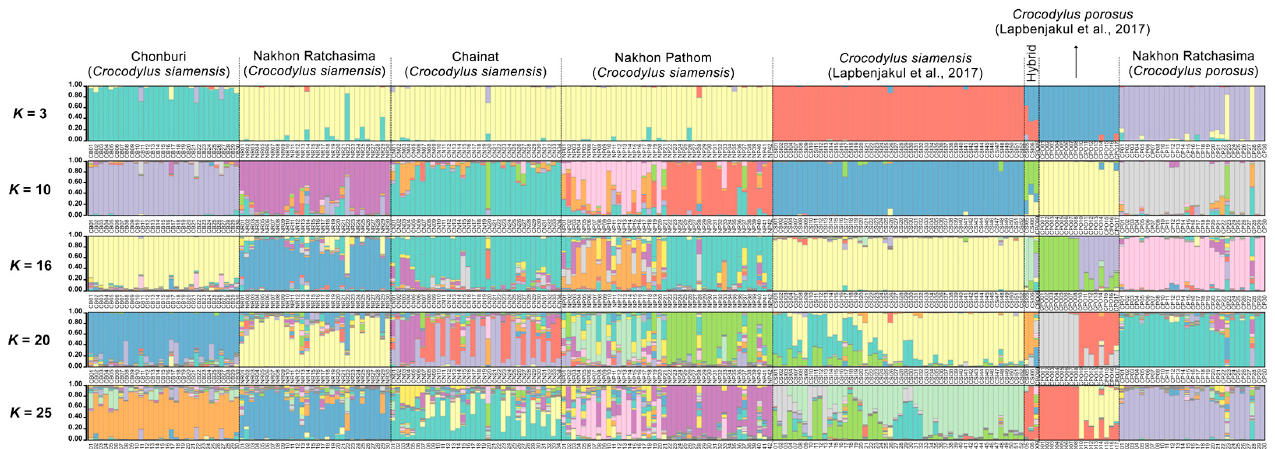
Figure 3. Population structure of 136 Siamese ( Crocodylus siamensis , Schneider, 1801) [1] individuals and 29 saltwater crocodile ( C. porosus , Schneider, 1801) [13] individuals. Each vertical bar on the x -axis represents an individual, while the y -axis represents the proportion of membership (posterior probability) in each genetic cluster. Crocodiles are superimposed on the plot, with black vertical lines indicating the boundaries. Detailed information for all crocodile individuals is presented in Table S1 and Lapbenjakul et al. [11].